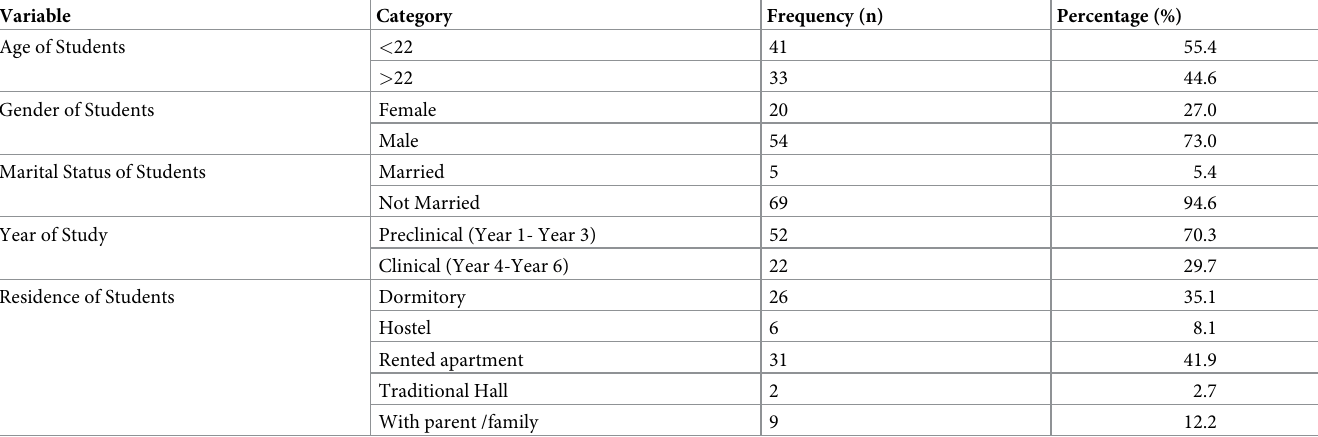
Table 1. Results of demographic characteristics of respondents.